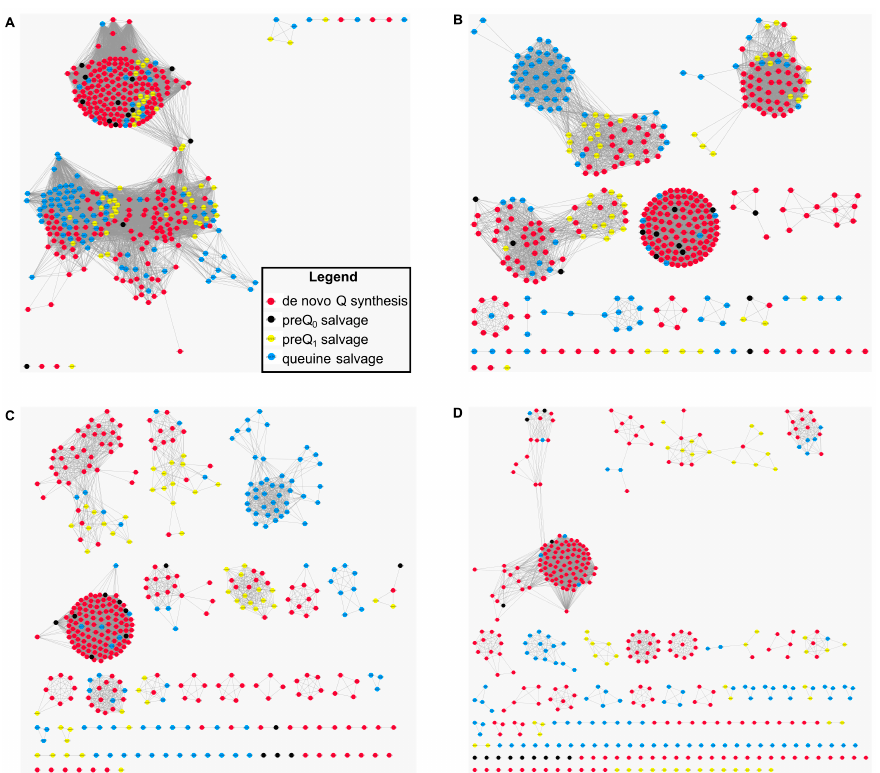
Figure 5. Protein sequence similarity networks (SSNs) for the analysis of the sequence relationships in the COG1738 protein family. YhhQ sequences were obtained from the pubSEED [35] subsystem “Queuosine bacterial salvage”, and colored depending on the configurations of salvage for preQ 0 , preQ 1 , queuine or the queuosine de novo synthesis capability of the organism from which they originate. SSN from a score of 20 ( A ); 40 ( B ); 60 ( C ); or 80 ( D ) tends to show that YhhQ proteins are